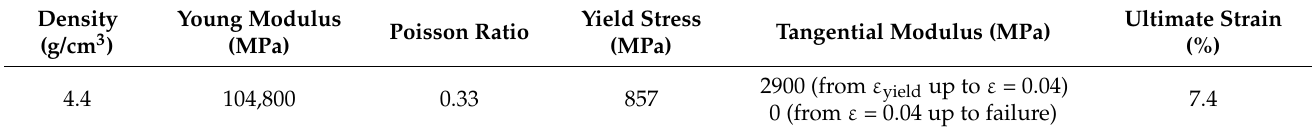
Table 1. Material mechanical properties.